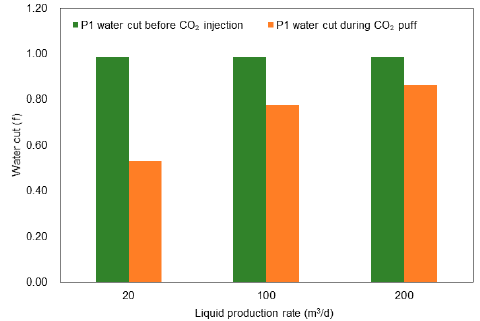
Figure 28. Influence of fluid production rate on water cut.